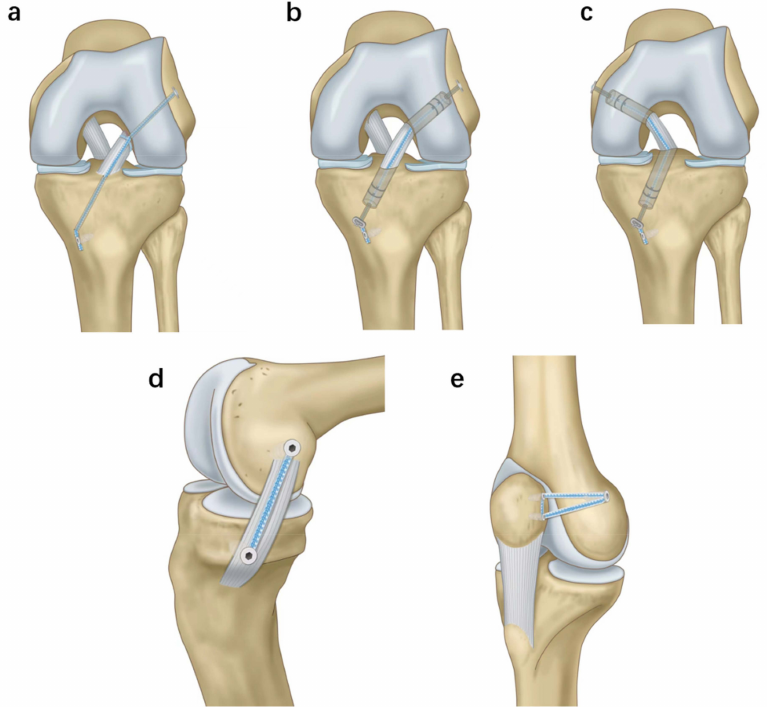
Figure 1. Surgical model of Internal Brace technique in knee ligament injuries. ( a ) Model of ACL repair combined with Internal Brace technology. ( b ) Model of ACL Reconstruction combined with Internal Brace technology. ( c ) Model of PCL Reconstruction combined with Internal Brace technology. ( d ) Model of MCL repair using Internal Brace technology. ( e ) Model of MPFL reconstruction using Internal Brace technique